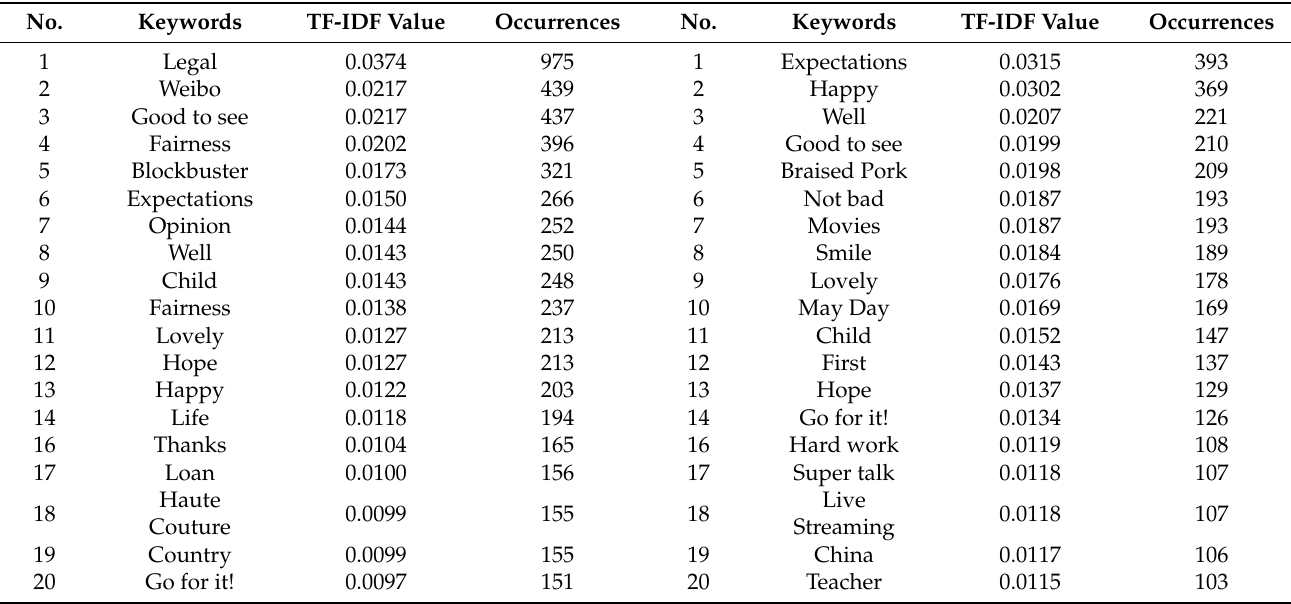
Table 4. Top 20 ranked keywords for B1 and